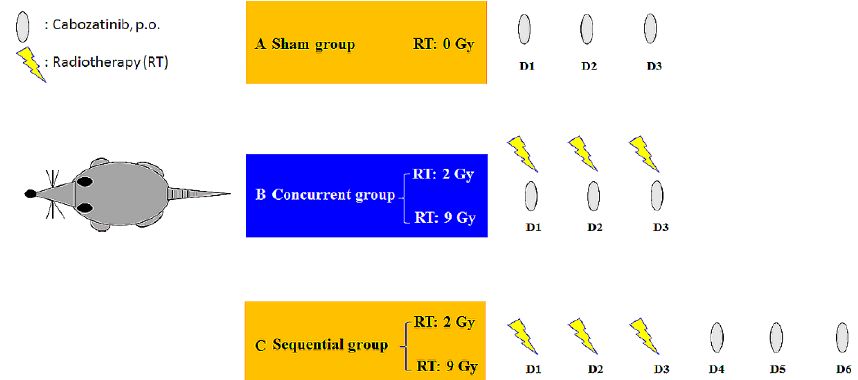
Figure 5. Oral cabozantinib (6 mg/kg p.o., q.d.) with radiotherapy (RT) under different time schedules and RT doses. The rats were divided into ( A ) a sham group, cabozantinib (p.o., q.d. × 3 d) with RT 0Gy (cabozantinib ×3d ); ( B ) a concurrent group, cabozantinib ×3d 1 h after RT 2Gy in 3 fractions (RT 2Gy ×3f’x ) and RT 9Gy×3f’x ; and ( C ) a sequential group, cabozantinib ×3d 24 h after RT 2Gy ×3f’x and RT 9Gy×3f’x . Data are expressed as the mean ± S.D. (n = 6 per group).